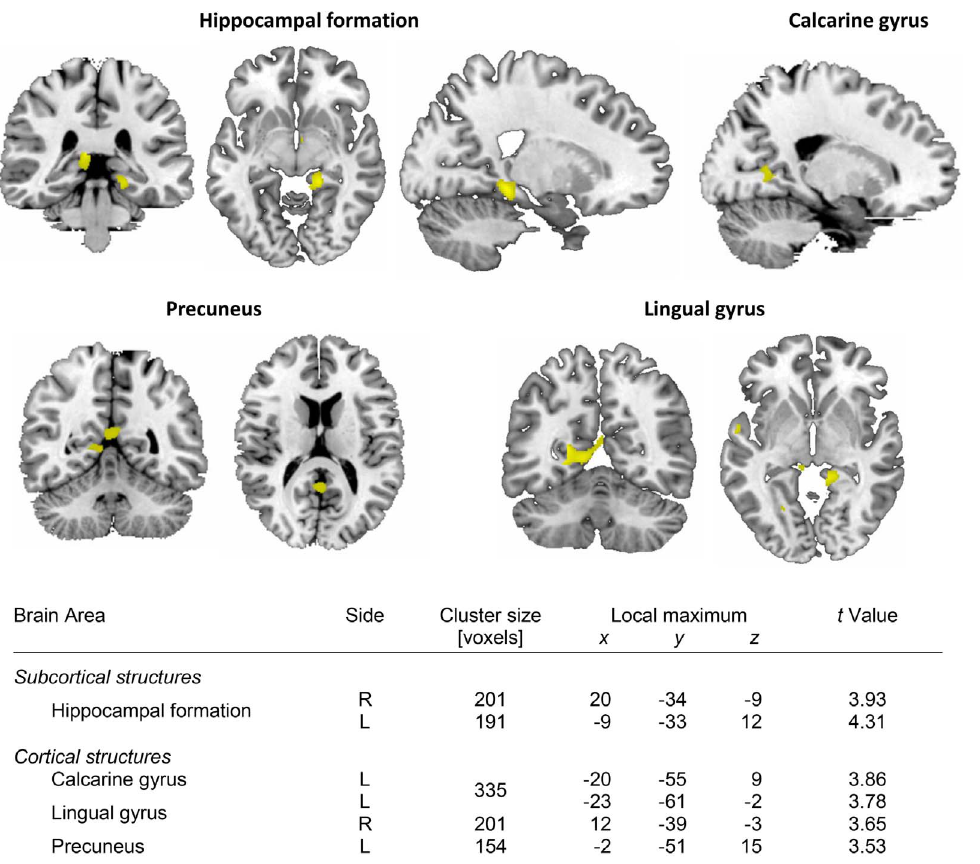
Figure 1. Brain areas which demonstrated decreased volume based on VBM analysis. Local maxima (MNI) correspond to slices depicted. P uncorrected , 0.001, cluster size . 20 voxels; expected false discovery rate: P , 0.02.